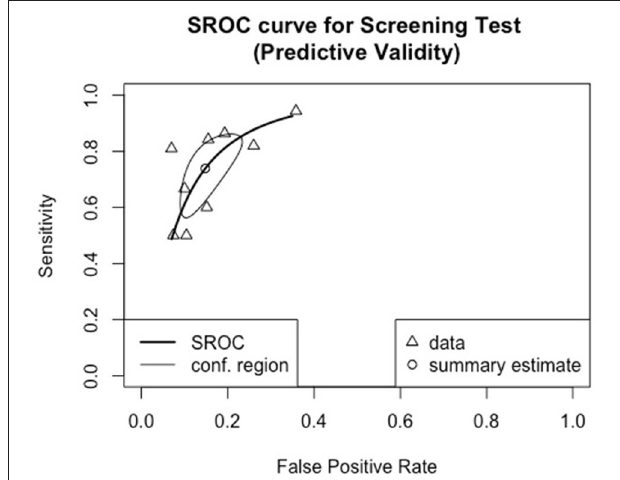
FIGURE 6 | Summary receiver operating characteristic curve for screening tools reporting predictive